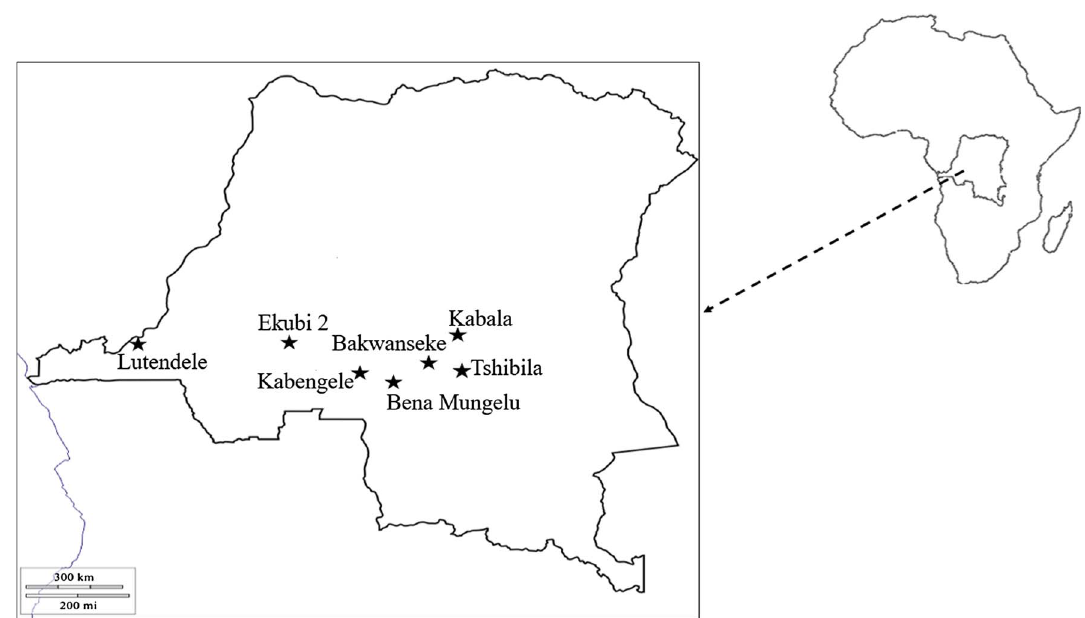
Figure 1. Map showing areas where tsetse fl ies were caught